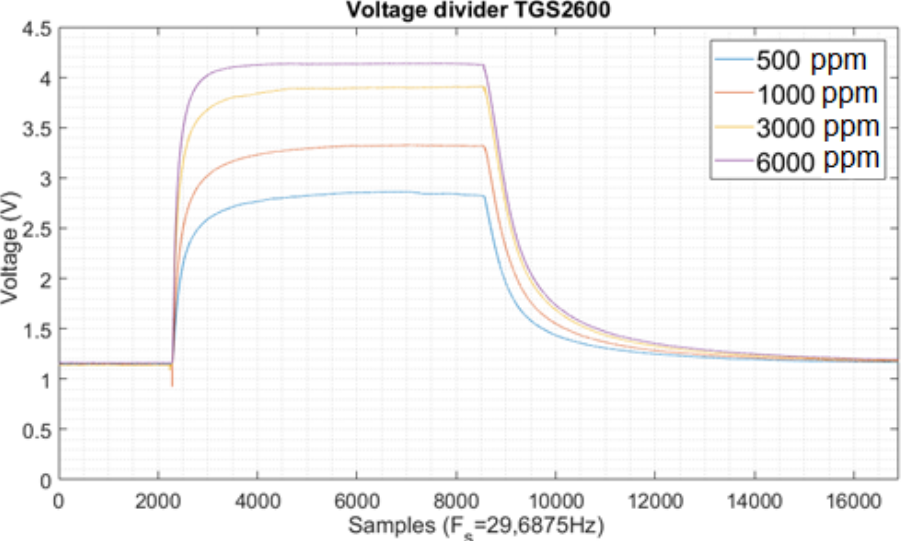
Figure 10. Voltage output for the voltage divider design with the sensor TGS2600.